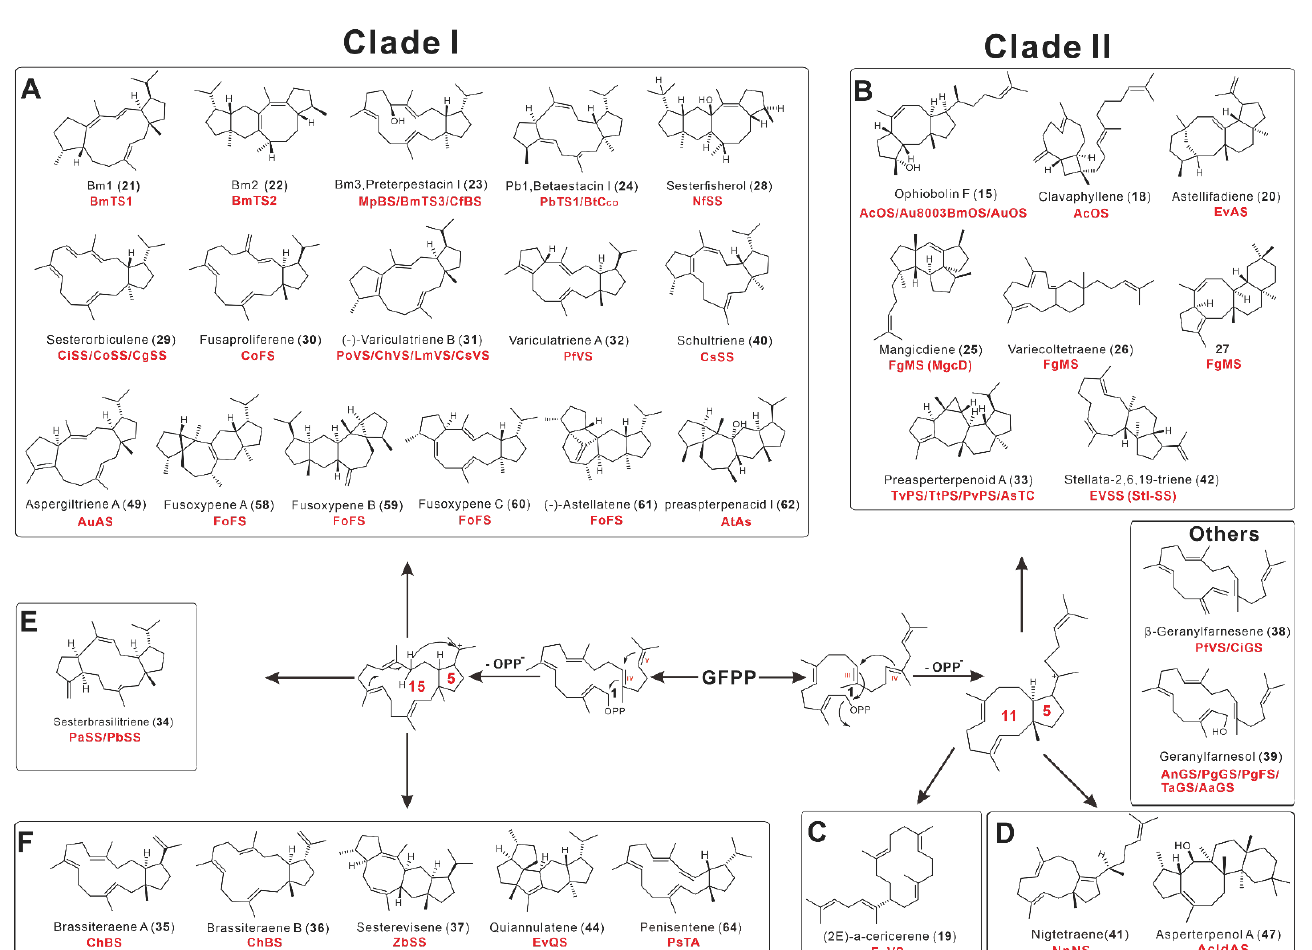
Figure 5. Summary of cyclization patterns of 52 fungal-derived PTTSs. ( A – F ) correspond to the six subfamilies of PTTSs.